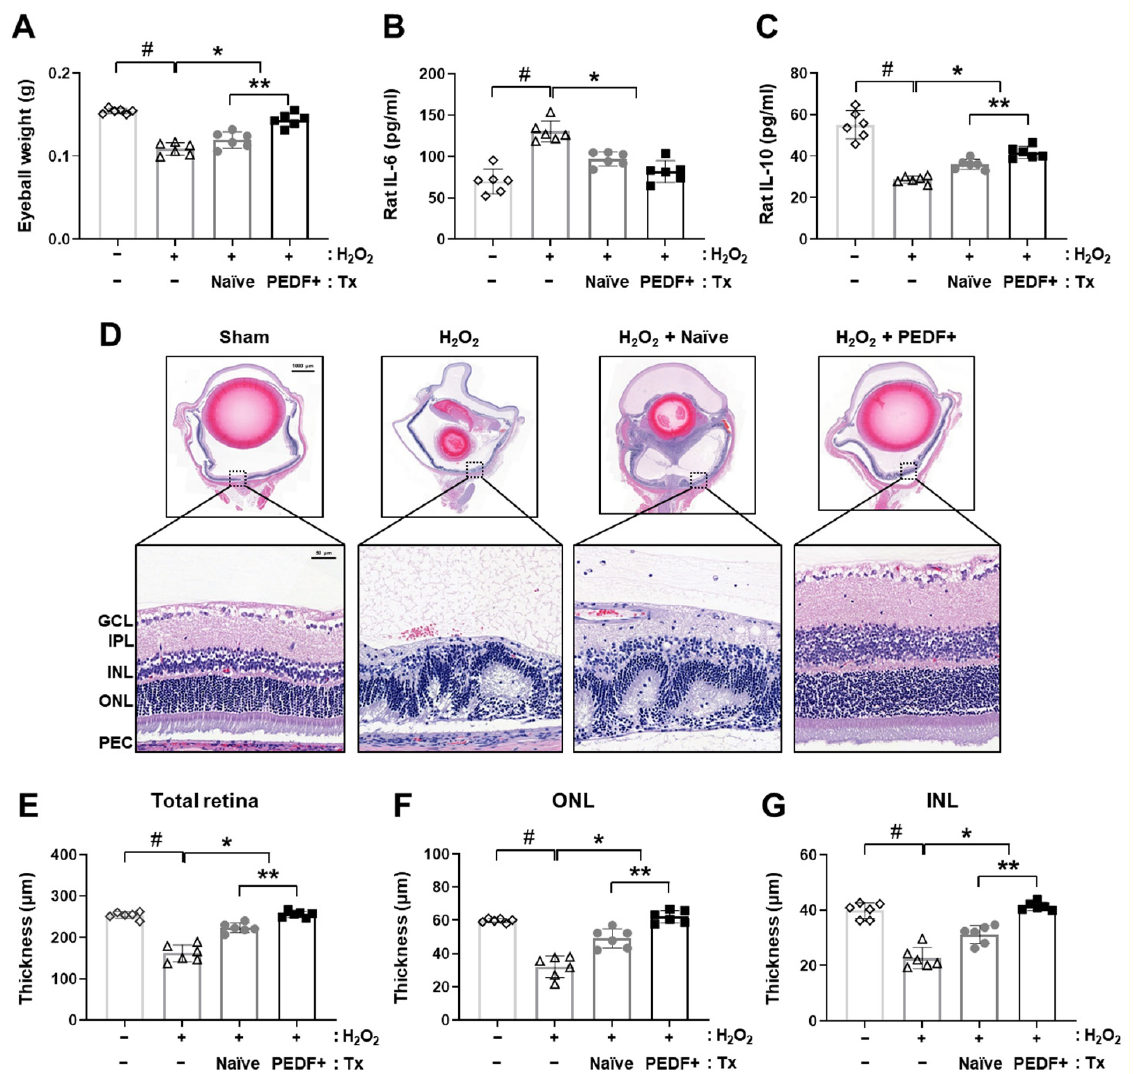
Figure 2. PD-MSC PEDF transplantation restores retinal function in a H 2 O 2 -injured rat model. ( A ) Eyeball weight (gram; g) in each group ( n = 6/group). We divided the rats into the following groups: sham, H 2 O 2 injection (H 2 O 2 ), intravitreal transplantation of naïve PD-MSCs (H 2 O 2 + Naïve), and PD-MSCs PEDF (H 2 O 2 + PEDF+). ( B ) The levels of the proinflammatory cytokine IL-6 and ( C ) anti-inflammatory cytokine IL-10 in rat serum from whole blood ( n = 6/group). ( D ) Histological images of H&E-stained rat eyeball sections. Measurement of ( E ) the total retina, ( F ) outer nuclear layer (ONL), and ( G ) inner nuclear layer (INL) in H&E-stained sections ( n = 6/group). The data represent the mean ± SD and were analyzed by one-way ANOVA. # p < 0.05 vs. Sham ( − ), * p < 0.05 vs. H 2 O 2 , ** p < 0.05 vs. H 2 O 2 + Naïve.